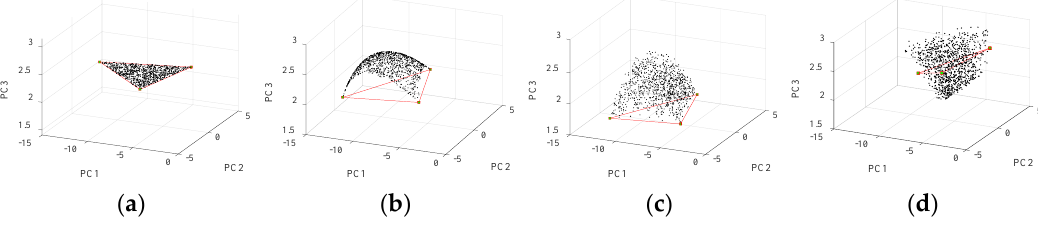
Figure 1. Geometric distribution of the data according to each model described by the three most significant principle components (PCs): ( a ) linear mixture model (LMM); ( b ) Fan model FM; ( c ) generalized bilinear model (GBM); ( d ) polynomial post-nonlinear model (PPNM). 2.2.